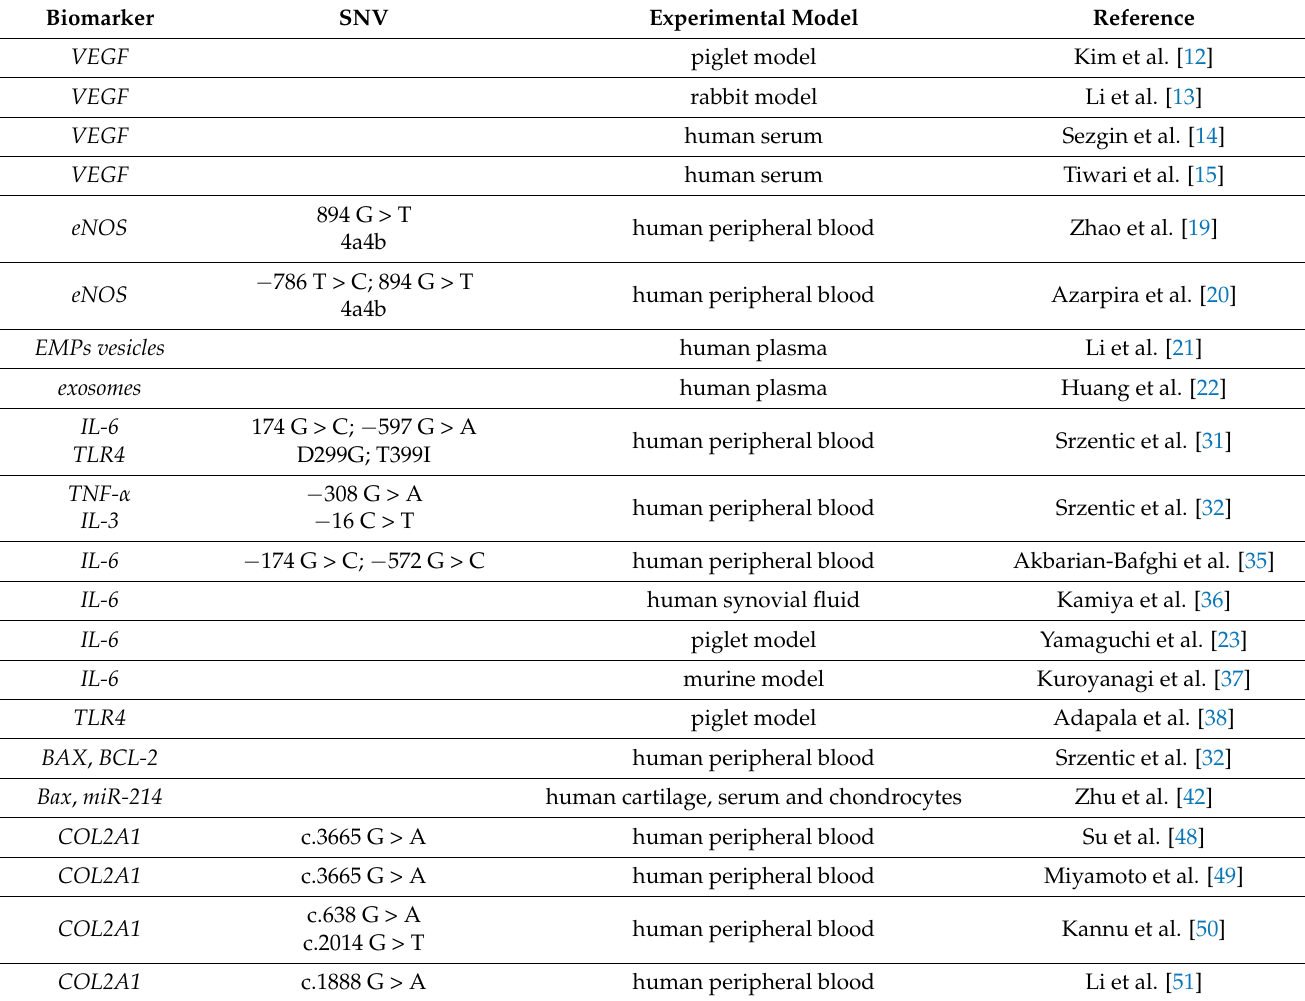
Table 1. Studies on biomarkers in Perthes